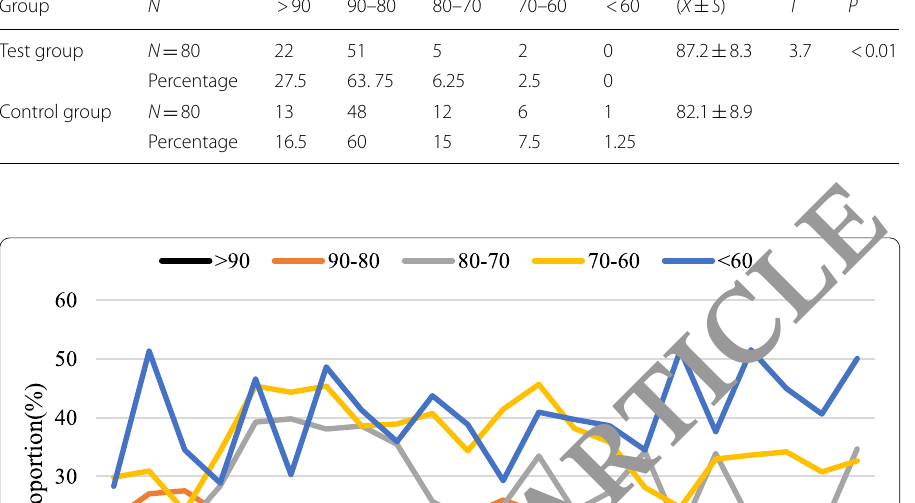
Fig. 2 The ratio of the number of people in each segment of the test group